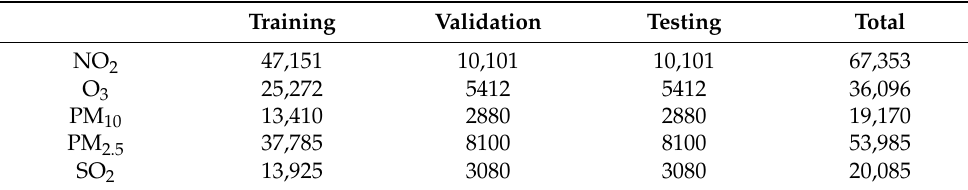
Table 3. Number of data points distributed to the training, validation and testing subset for the 2016/2017 time period.